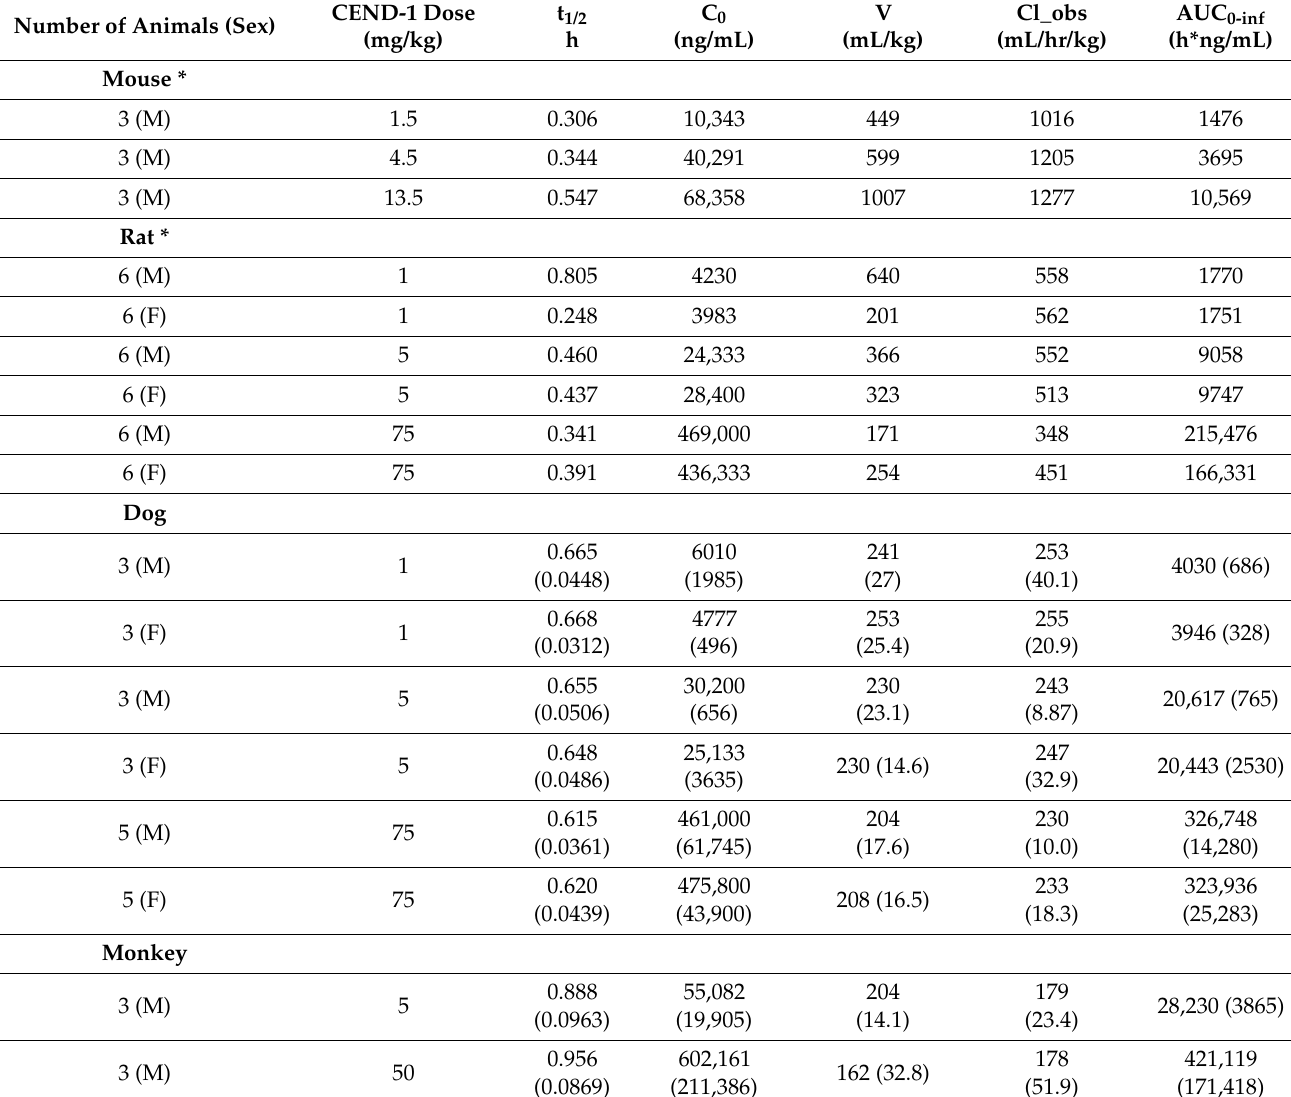
Table 1. Derived mean pharmacokinetic parameters for CEND-1 in mouse, rat, dog and monkey plasma after a single intravenous infusion of CEND-1 ( ±